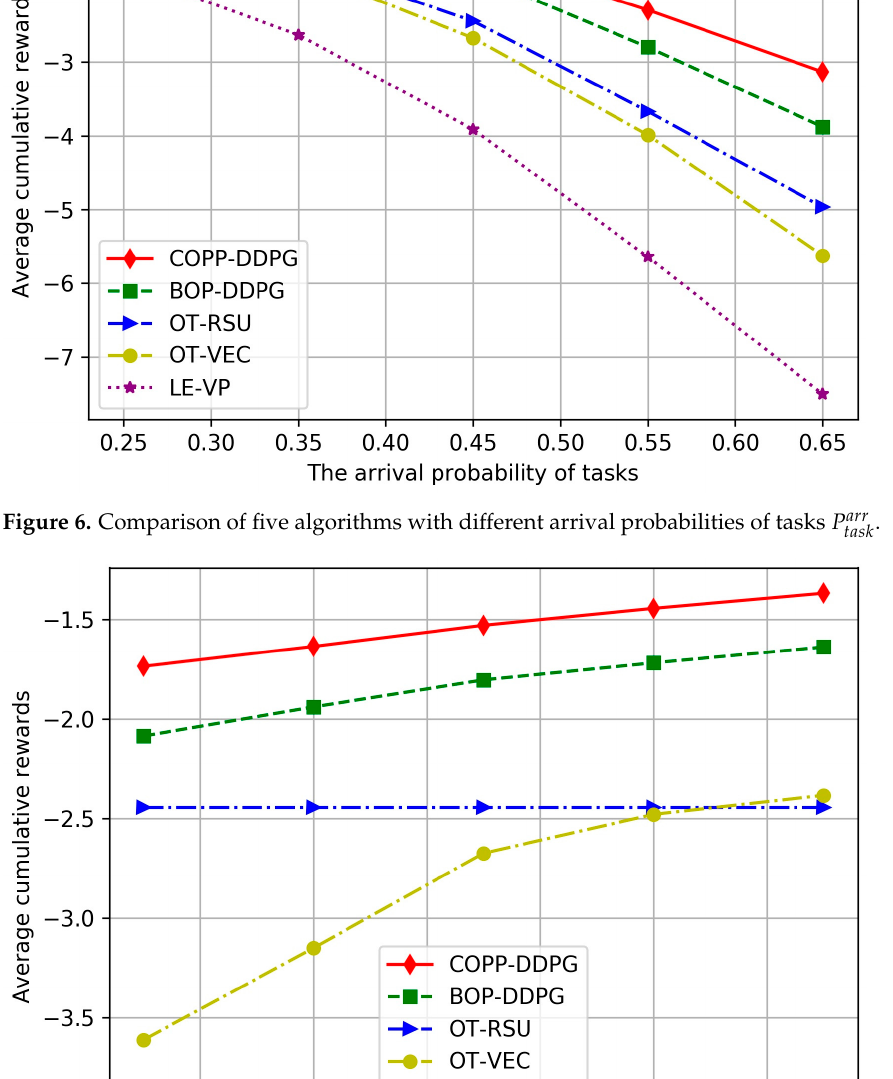
Figure 7. Comparison of all algorithms with different computational capacities of VEC.